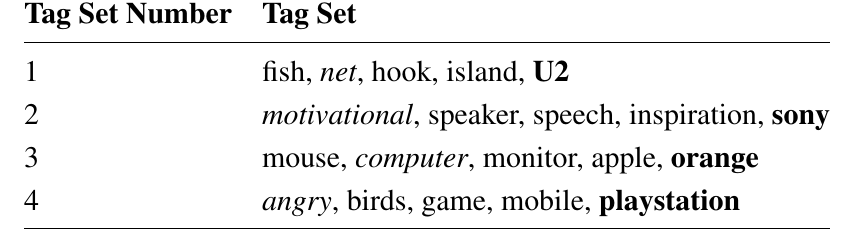
Table 3. Example of Tag Sets where the judgment of our algorithm proved inadequate. (Human adjudged anomalous tags are shown in bold. The ones detected by our algorithm are shown in